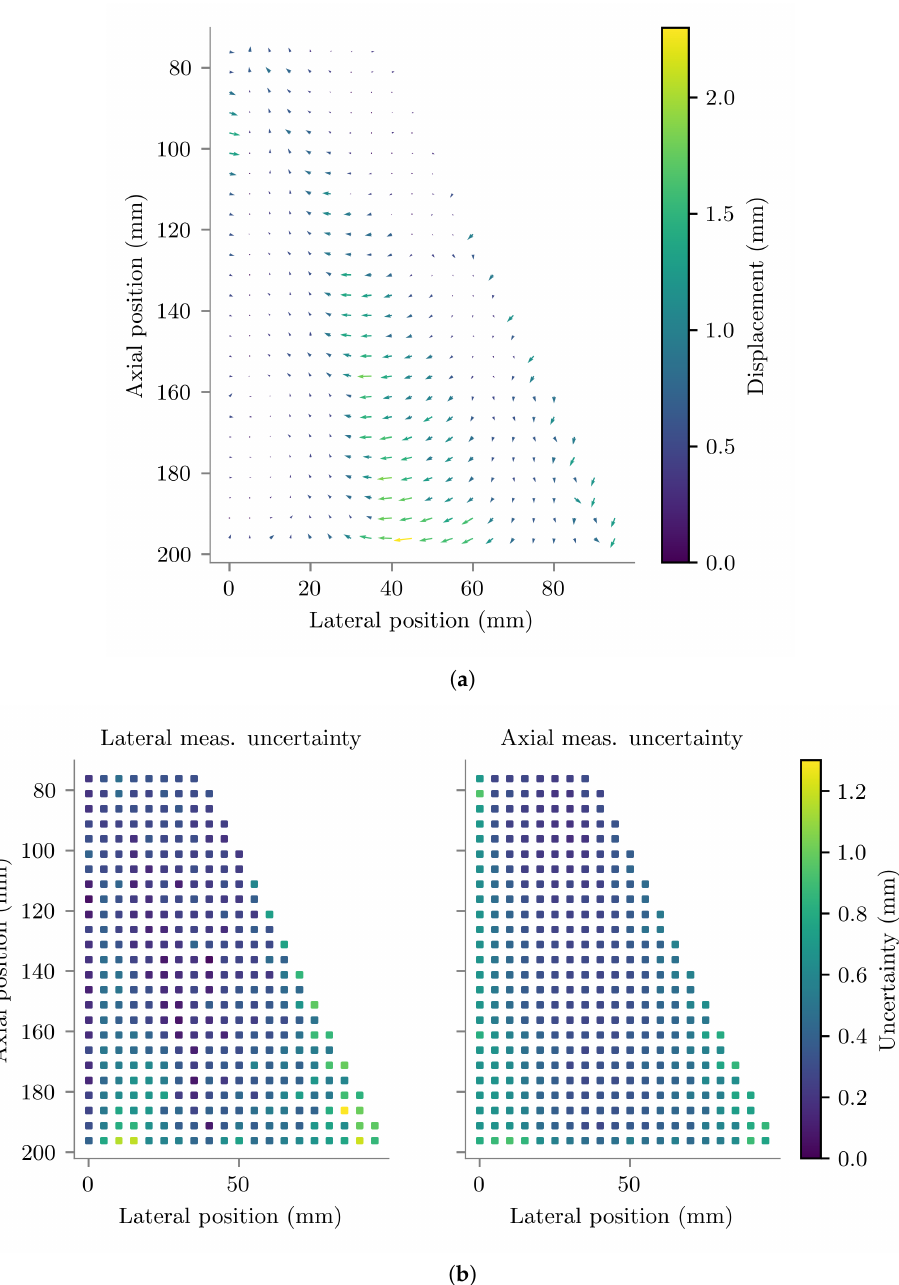
Figure 9. ( a ) Average vector displacement between tracked and true positions measured in water. Each arrow has its base at a true position and points in the direction of the displacement. For visibility, the arrows have been drawn with lengths equal to twice the displacement magnitude. True displacement magnitudes are indicated by the colour bar. ( b ) Random uncertainty of the measurements plotted in ( a ). Lateral and axial positions are relative to the centre of curvature of the US imaging